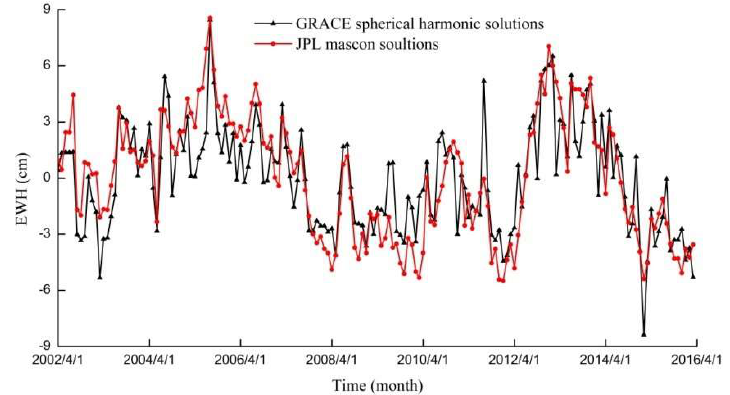
Figure 5. TWSA of GRACE spherical harmonic solutions and JPL mascon solutions over the Liao River Basin from April 2002 to March